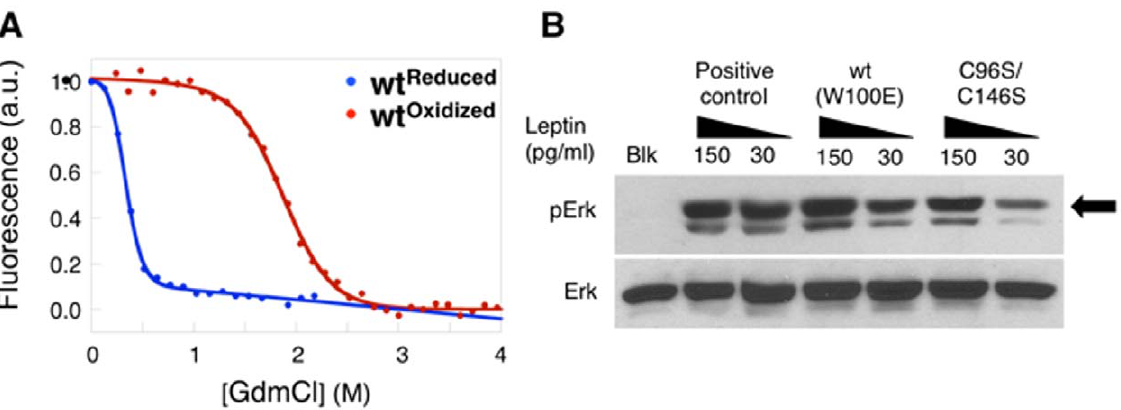
Figure 6. Experimental demonstration of the relative cooperativity of unfolding and signalling activity of WT and mutant leptin. (A) The equilibrium unfolding curves show the reduced (blue) and oxidized (red) states of leptin. The plots show that the oxidized protein is more stable then the reduced protein. (B) The activity assay was performed on human MCF-7 cell lines. We used a blank (Blk) to test the normal expression in these cell lines (Erk), a positive control (mouse leptin, purchased from Calbiochem) our purified oxidized leptin wt and our mutated leptin C96S/ C146S, from left to right respectively. Stimulation results in the production of phosphorylated forms of Erk as indicated by the arrow (pErk).